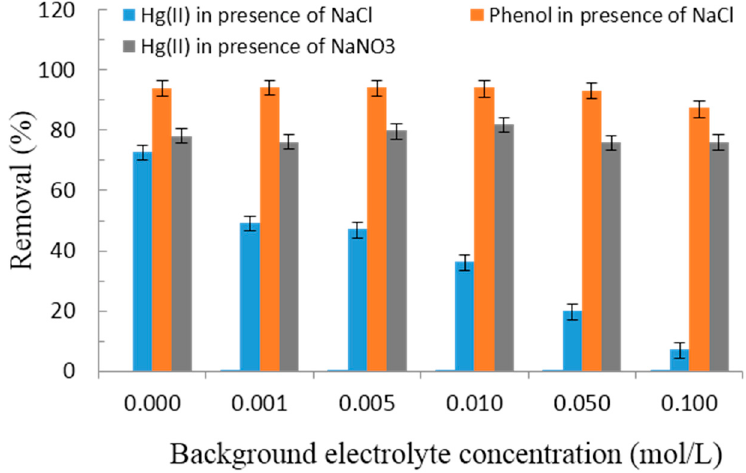
Figure 9. Effect of background electrolyte concentrations in the removal of Hg(II) and phenol by modified-AC from aqueous solutions (Initial (Hg(II)/phenol) concentrations: ~10 mg/L, pH: 5.0, solid dose: 2.0 g/L, contact time: 12 h, background electrolyte: NaCl/NaNO 3 ).